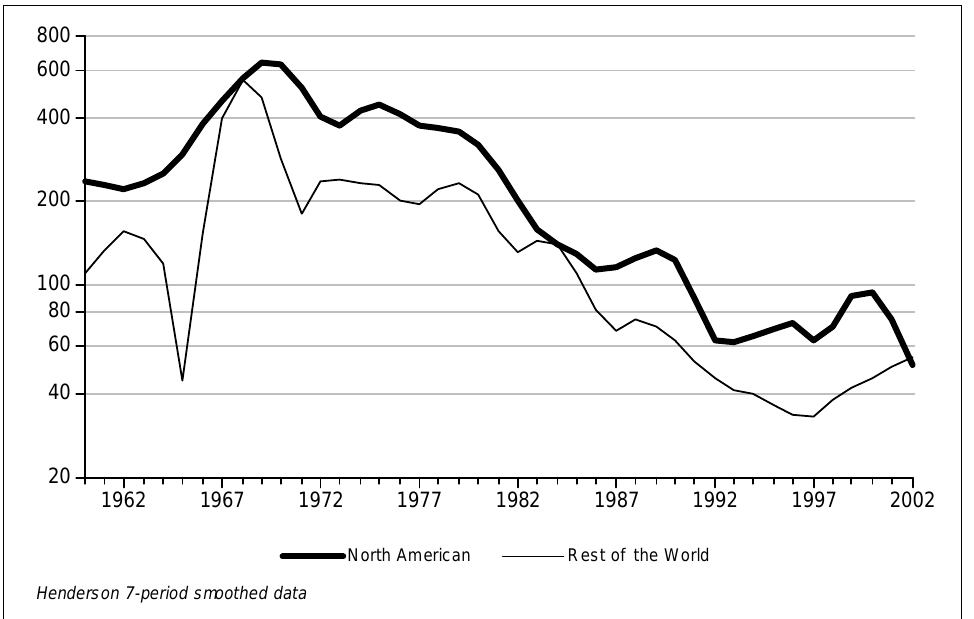
Figure 3. Smoothed Stoppage Rates - North America and the Rest of the